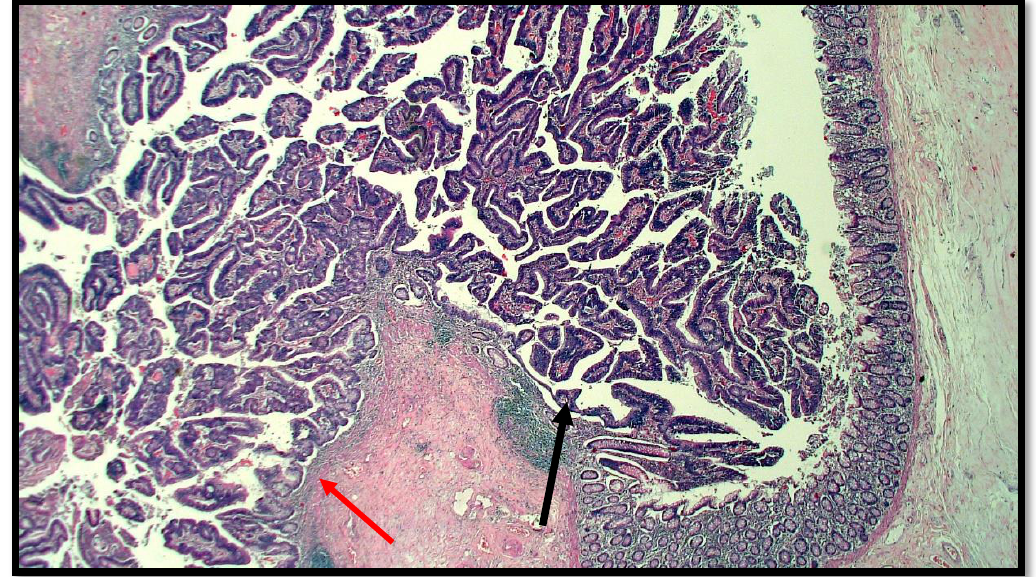
Figure 1. Histological preparation of intestinal-type adenocarcinoma (black arrow) arising on villous adenoma with high grade dysplasia (red arrow) (hematoxylin–eosin, original magnification: 10×).